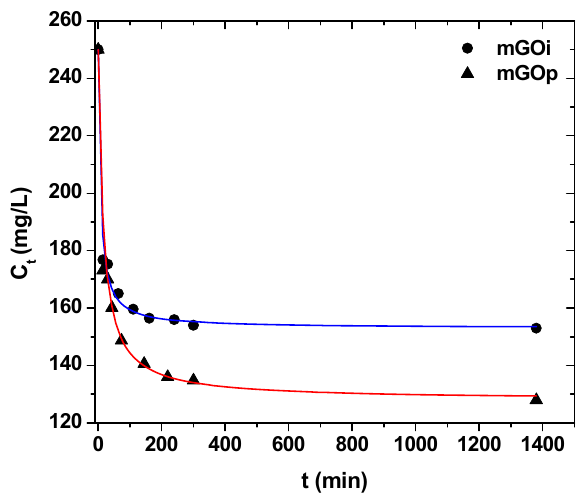
Figure 8. Effect of contact time on RB5 removal.